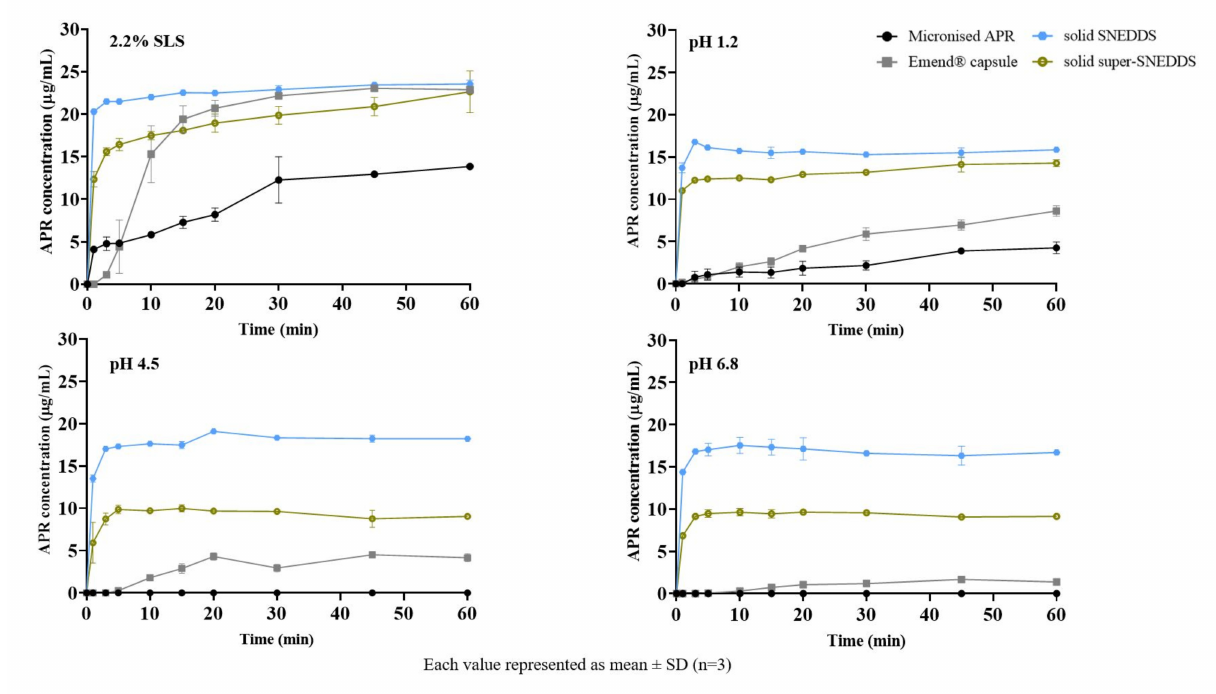
Figure 12. In vitro drug release from formulations in different